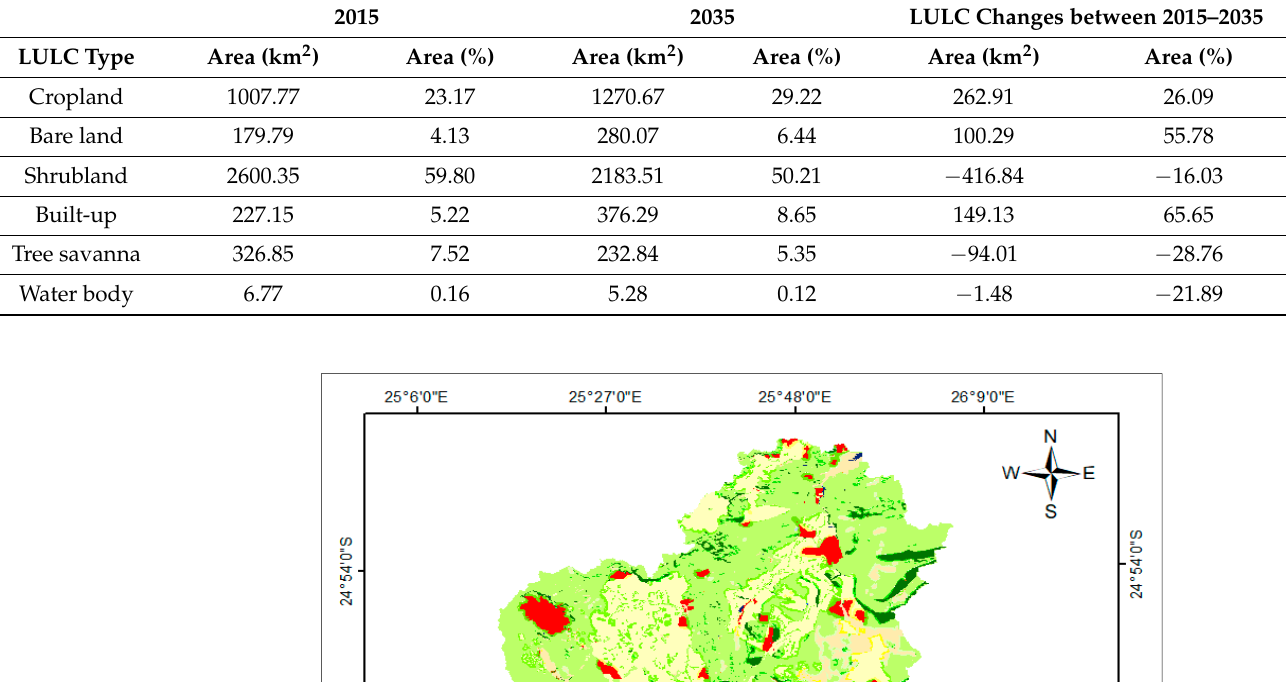
Table 6. LULC change distribution from 2015–2035.